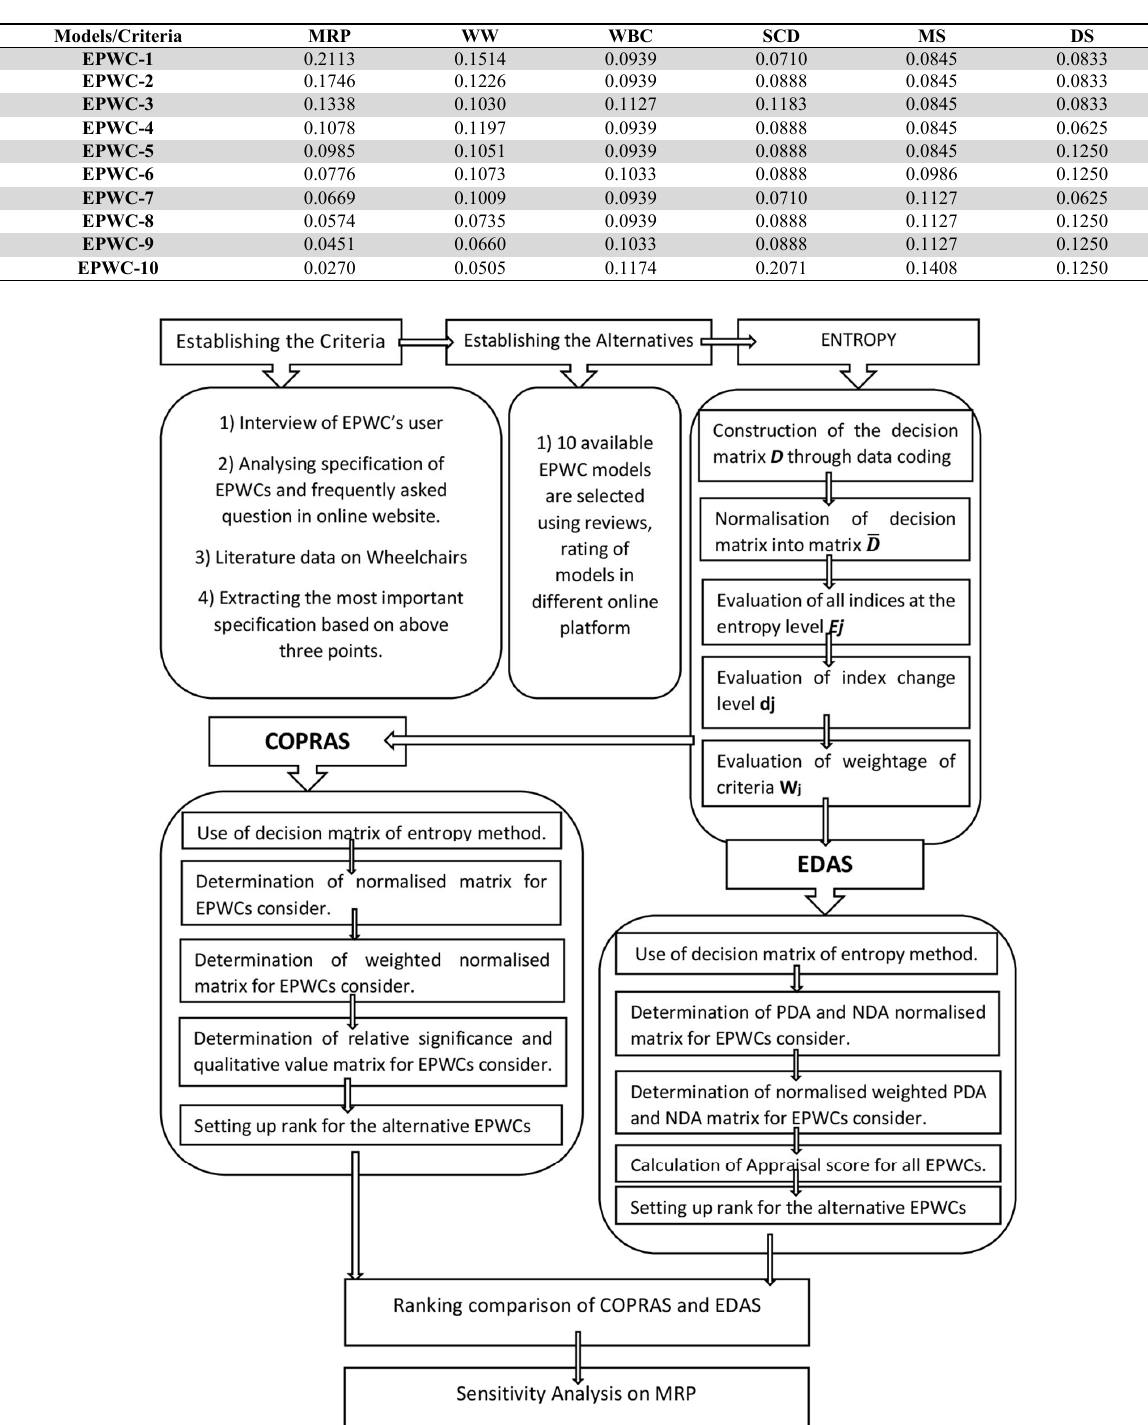
Fig. 2. Flowchart of the complete evaluation process by ENTROPY, COPRAS, and EDAS MCDM Methods Determining the entropy level for each of the parameters Ej using Eq. (5) as follows: = − g E (cid:2920)